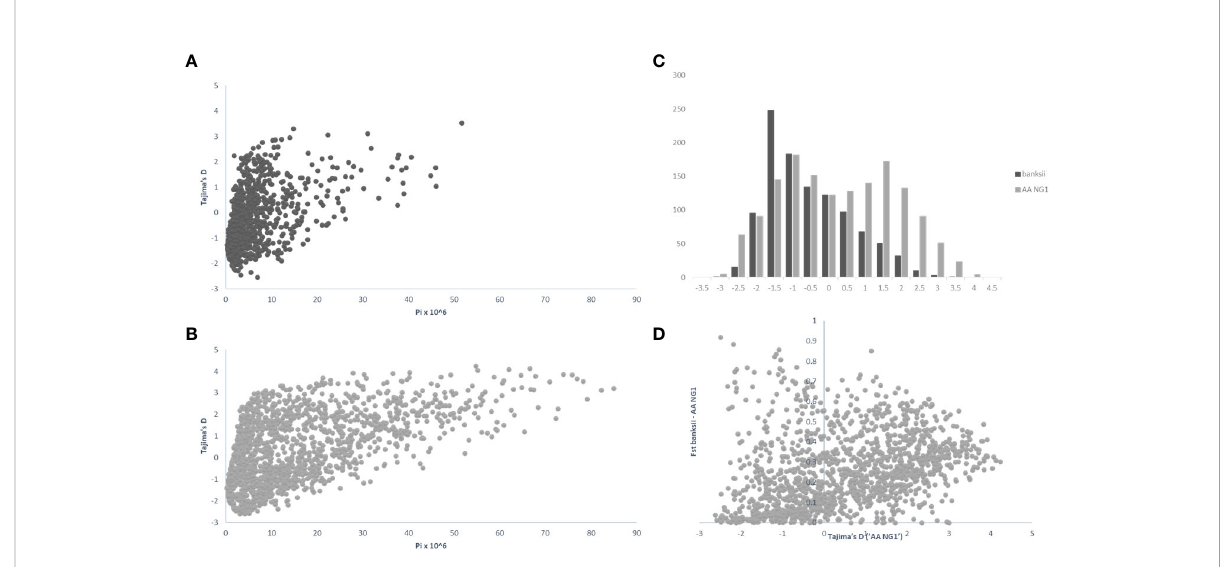
FIGURE 5 Distribution of pi ( p ), Tajima ’ s D and Fst calculated on 200 kb windows along the genomes for the clusters ‘ banksii ’ and ‘ AA NG ’ (Q banksii >90%). Tajima ’ s D plotted against pi ( p ) for ‘ banksii ’ (A) and ‘ AA NG ’ (B) ; comparative distribution of Tajima ’ s D values (C) and Tajima ’ s D calculated for ‘ AA NG ’ plotted against Fst between ‘ banksii ’ and ‘ AA NG ’ (D)